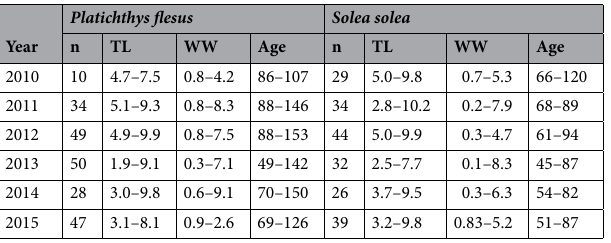
Table 1. Summary of the number of Platichthys flesus and Solea solea specimens per year (n), with the respective range in total length (TL, cm), wet weight (WW, g) and age (days).